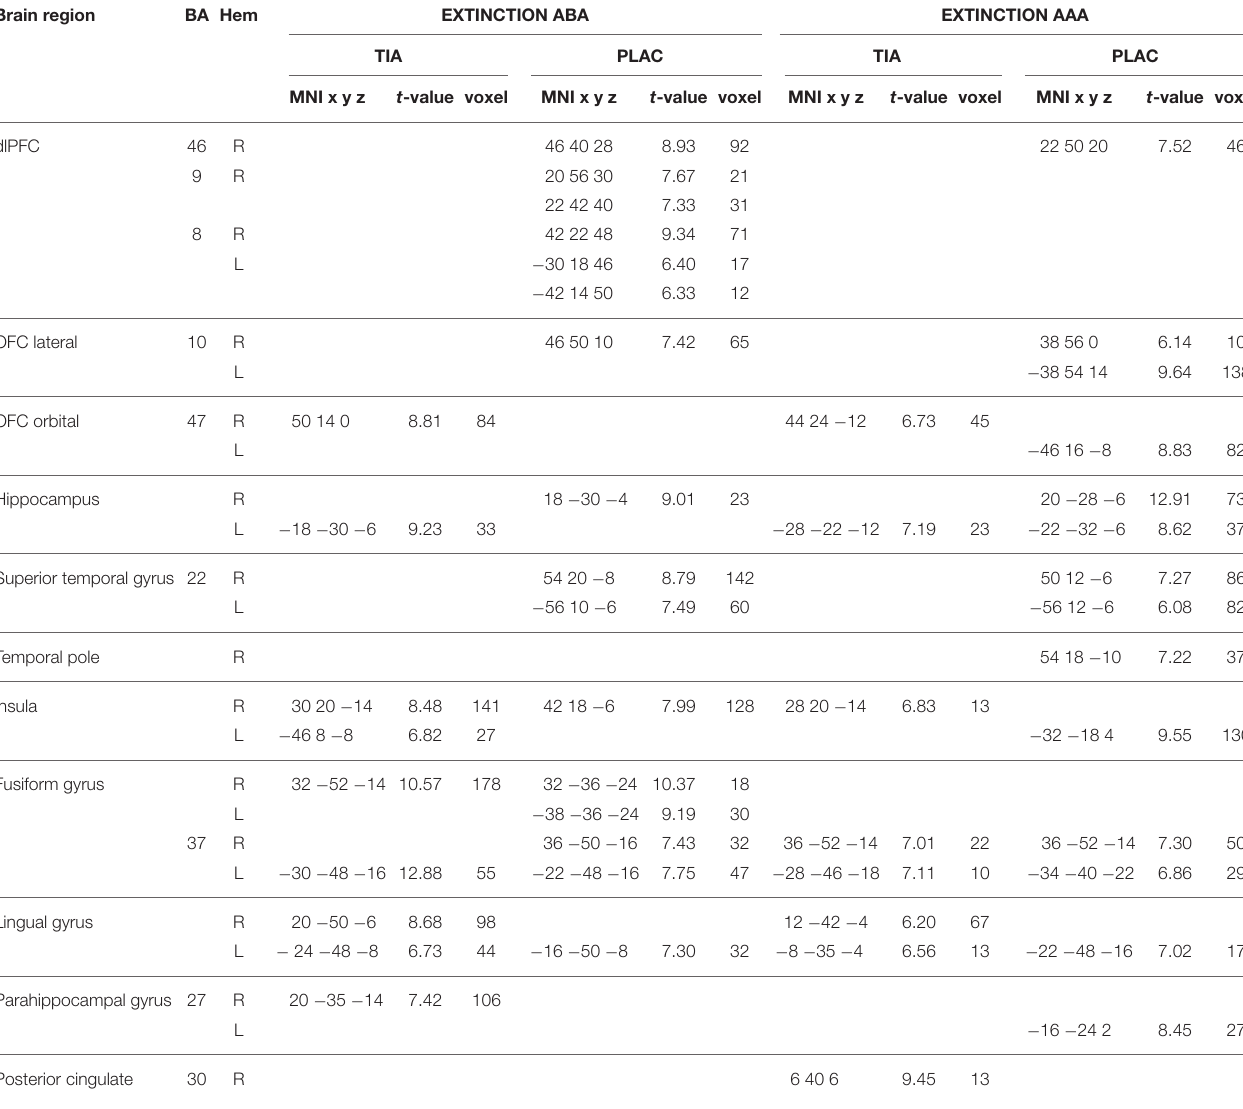
TABLE 1 | One-sample tests—activated regions in TIA and PLAC during Extinction learning p < 0 . 001 FWE-corrected, k = 10 . Brain